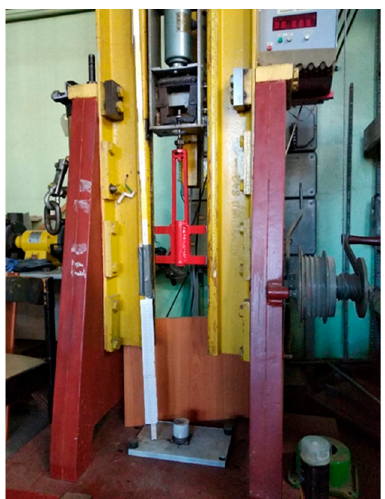
Figure 1. Lightweight Shock Machine in the laboratory of Polish Naval Academy.